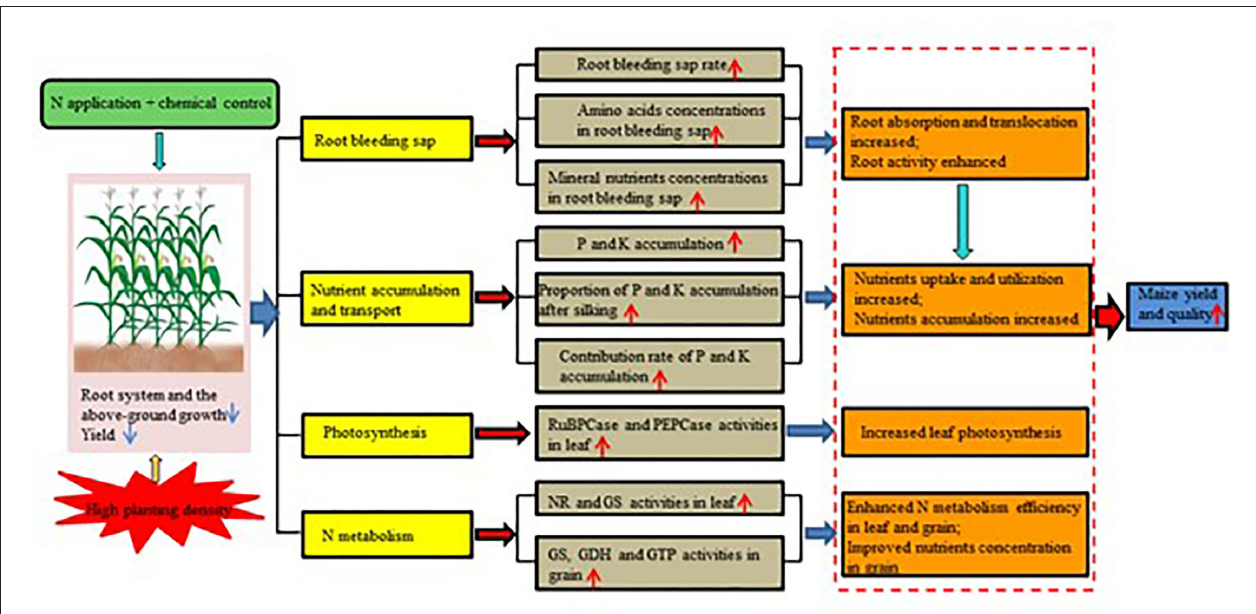
FIGURE 6 | The schematic representation of nitrogen fertilizers and chemical control regulated maize yield. The red arrows ( ↑ ) and the blue arrows ( ↓ ) represent the positive and passive roles of treatment,